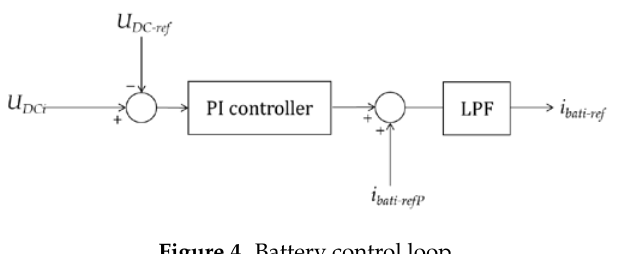
Figure 4. Battery control loop.